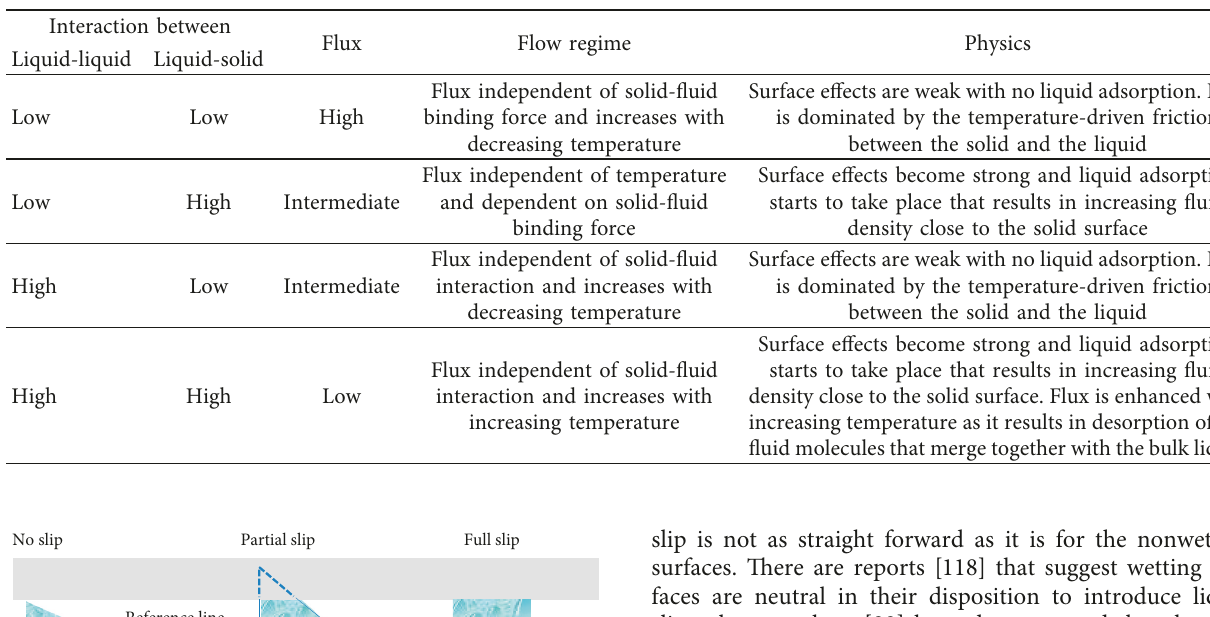
Figure 4: (a) Variation of flux values as a function of fluid-wall interaction and fluid-fluid interaction, and (b) graphical representation of corresponding liquid flow regimes. Table 2: Different flow regimes as a function of liquid/solid binding